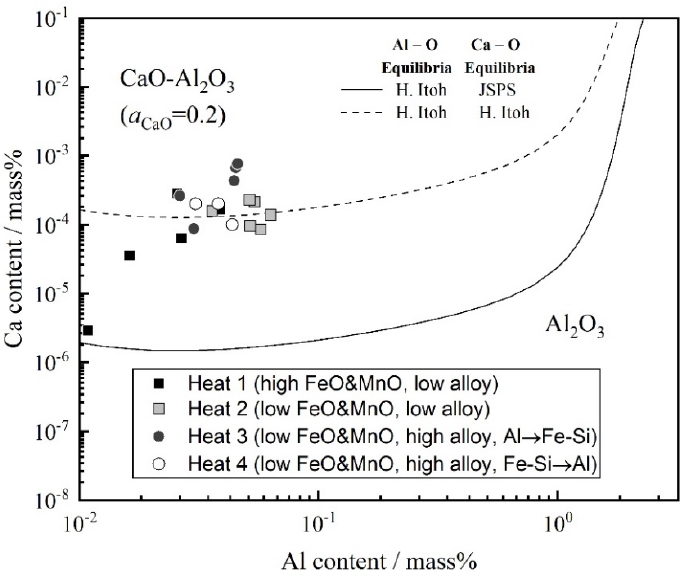
Figure 19. Projection of the steel compositions on the Al 2 O 3 /CaO–Al 2 O 3 stability diagram.